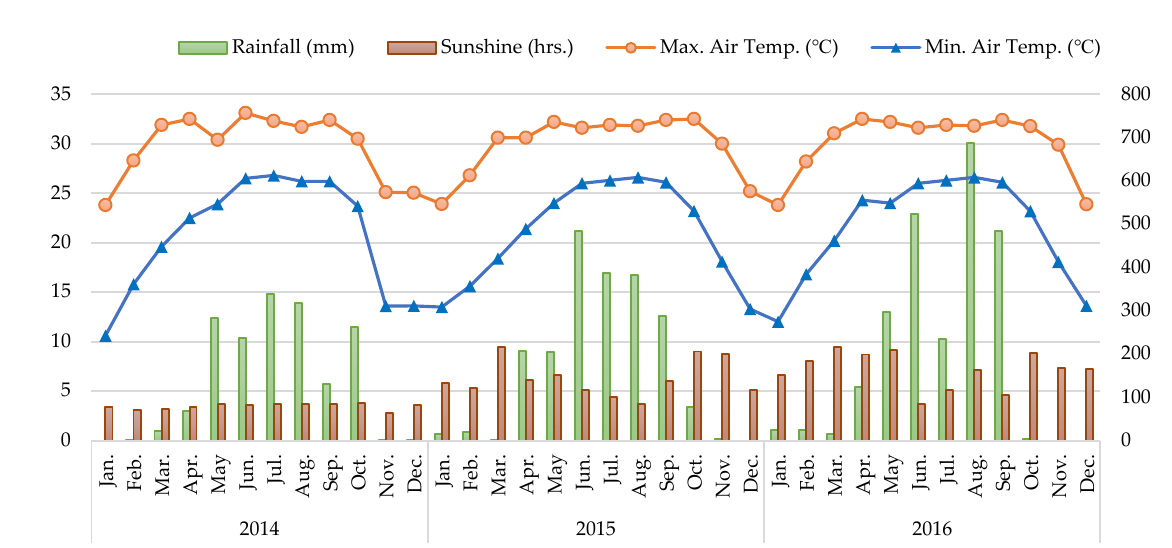
Figure 1. Monthly average temperatures, precipitation, and daylight hours in 2014–2016 of the Durbachara zone of Bangladesh.